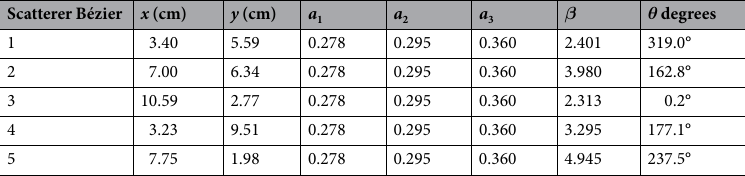
Table 2. Parameters of the five Bézier scatterer defining the optimum cloak. A given scatterer is centered at the position with coordinates ( x , y ). Note that all the scatterers have the same shape parameters, a i . The rest of scatterers forming the cloak are obtained by symmetry